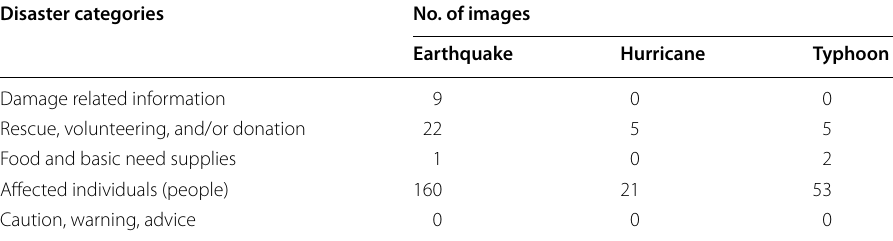
Table 11 Classification of test dataset on the taxonomy of emergency response using YOLOv4 Disaster